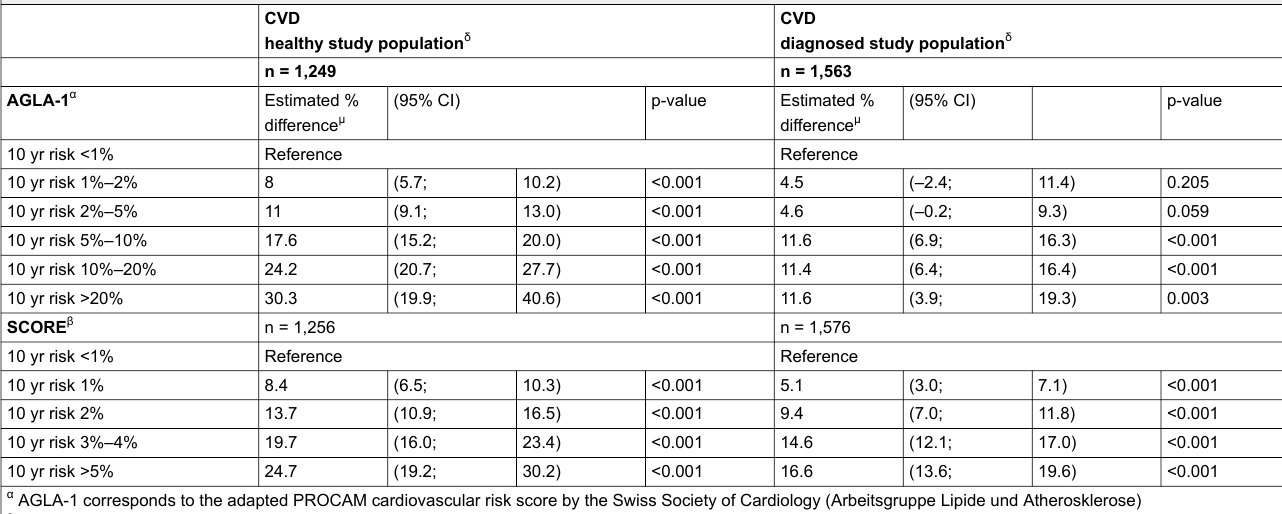
Table 2: Association of AGLA-1 and SCORE with aCIMT in SAPALDIA 3 by doctor diagnosed CVD status in SAPALDIA 2 and SAPALDIA 3. CVD healthy study population δ n = 1,249 n = 1,563 AGLA-1 α Estimated % difference μ Reference Reference